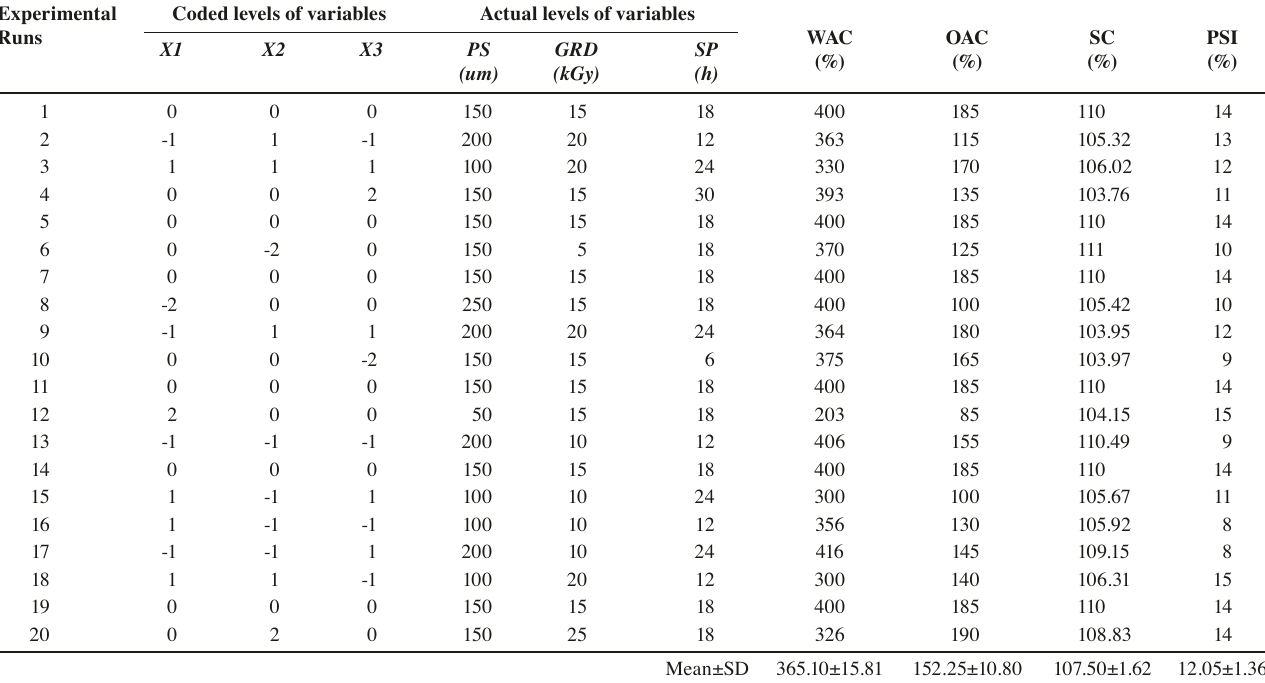
Tab. 2: Functional properties of N. nucifera rhizome flour at various combinations of input variables selected by CCD.